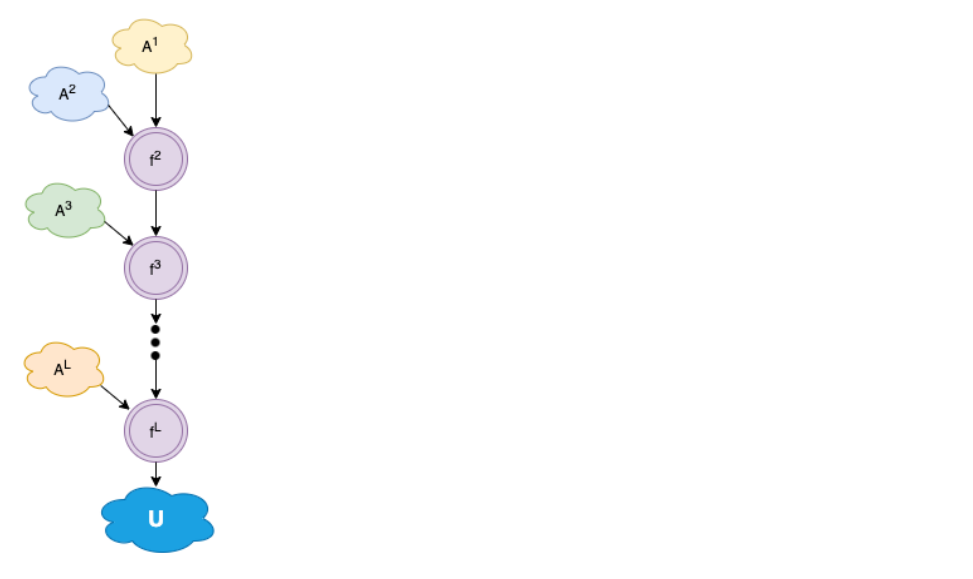
Figure 1. Action space composition. The final action space U is constructed by chaining multiple action component’s subspaces A i